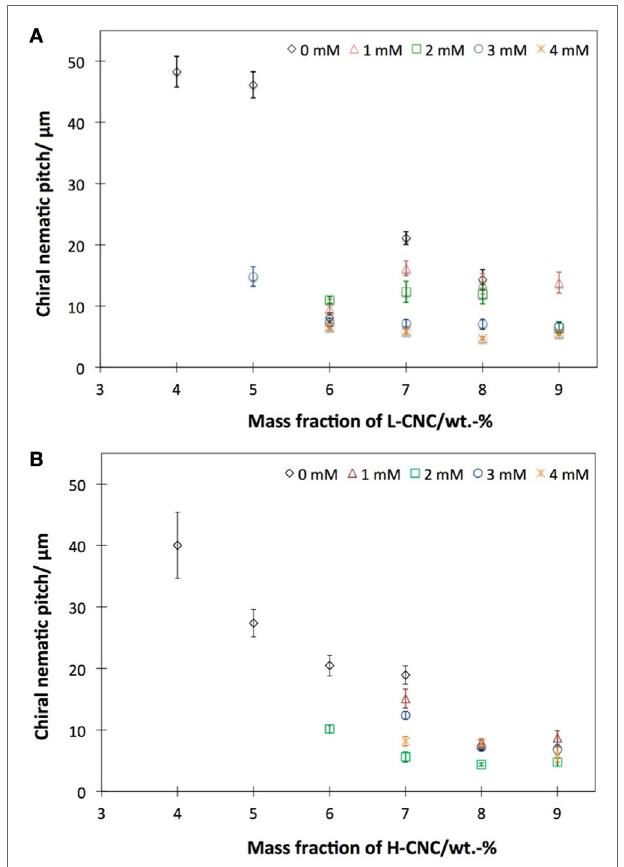
FigUre 8 | approximate helix pitch in the chiral nematic phase of aqueous suspensions of (a) l-cnc and (B) h-cnc, as estimated from fingerprint textures in glass capillaries . Data plotted as diamonds are without added salt, while the other series represent varying amounts of added